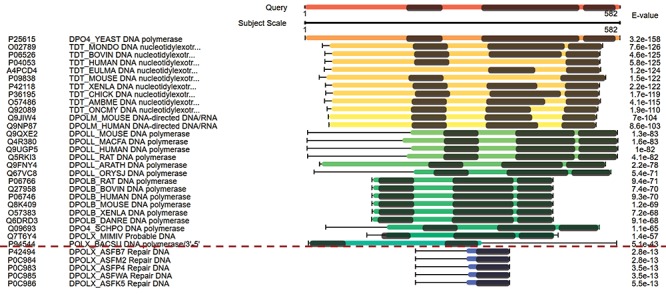
The combined domain and sequence alignments in the view of multiple hits easily excludes false-positive hits. The first column from the left side refers to the accession numbers of hits, the second column refers to the protein descriptions, the third column virtualizes the alignments and the last column indicates the E-values of the hits.